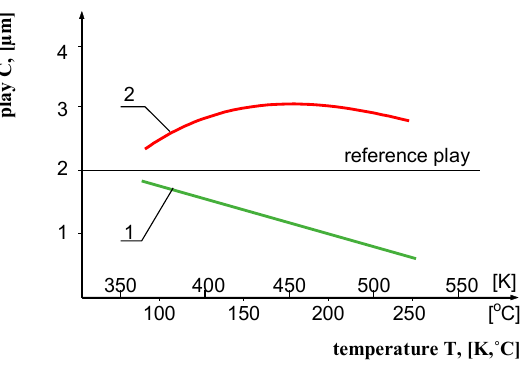
Figure 3. The play in the needle-nozzle holder precision pair of injector 7 as a function of operating temperature: 1—factory needle, 2—needle following additional thermal processing.